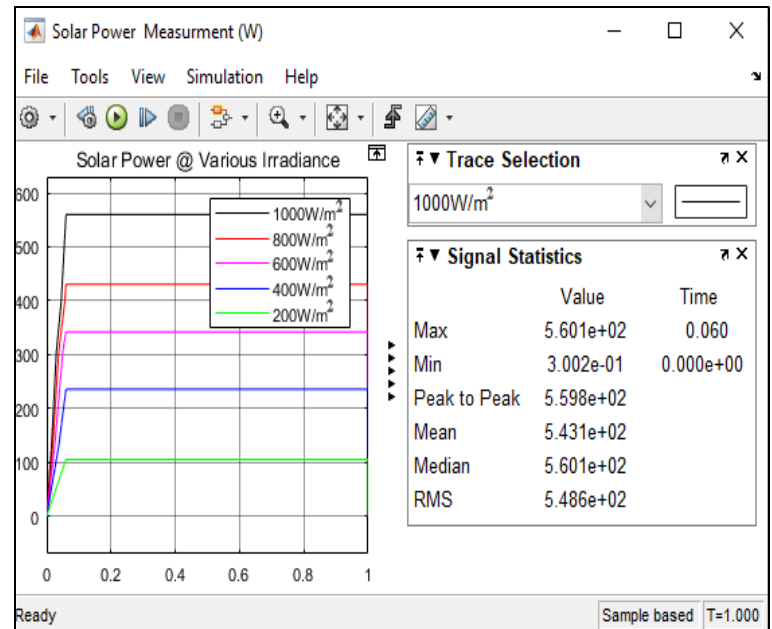
Figure 8. P solar at different irradiance settings by ANFIS model. For practical utilisation, the input irradiance changes with respect to the geographical location of the device. The profile of solar irradiance was defined in four conditions at total daytime (TDT), namely, (1) 1000 W/m 2 at 30% TDT, (2) 500 W/m 2 at 30% TDT, (3) 200 W/m 2 at 30% TDT, and (4) 0 W/m 2 at 10% TDT. Using signal statistics from the Simulink model, the mean P solar /specific period was 495.4 W.